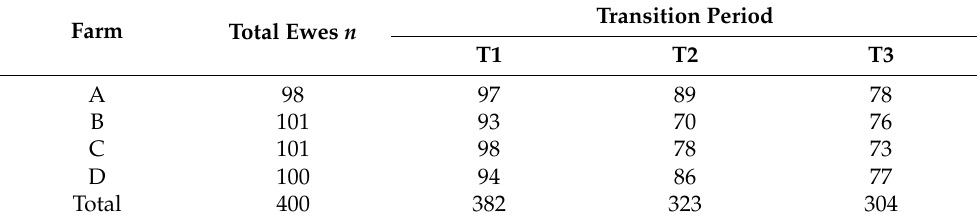
Table 7. Distribution of ewes ( n = 400) by farm and transition period. Farm Total Ewes n